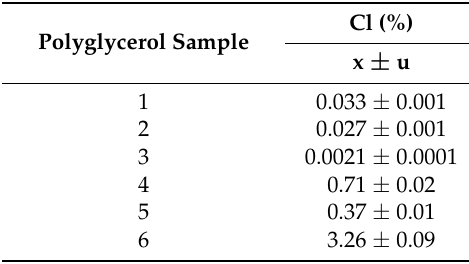
Table 3. The results of chlorine determination in selected polyglycerol samples by using inductively coupled plasma mass spectrometry (ICP-MS) method developed in this work (average (x) ± confidence interval (u), n = 3, 95% confidence